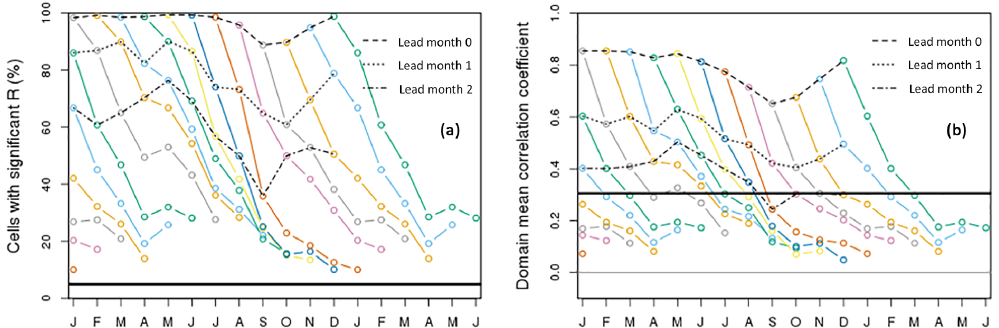
Figure 5. (a) Fraction of cells with significant skill (in terms of R ), and (b) domain average correlation in the run-off hindcasts, as a function of initialisation month and lead time. Each coloured curve corresponds to the hindcasts initialised in a single month. For better visualisation, parts of the curves that end in the next year are shown twice, namely at the left-hand and the right-hand side of the graph. Black lines (dashed, dotted and dashed–dotted) connect the results for identical lead times. The horizontal line in (a) shows the expected fraction of cells with significant skill, in the case that the hindcasts have no skill at all (5%), and in (b) the minimal magnitude of the correlation of a single cell for it to be statistically